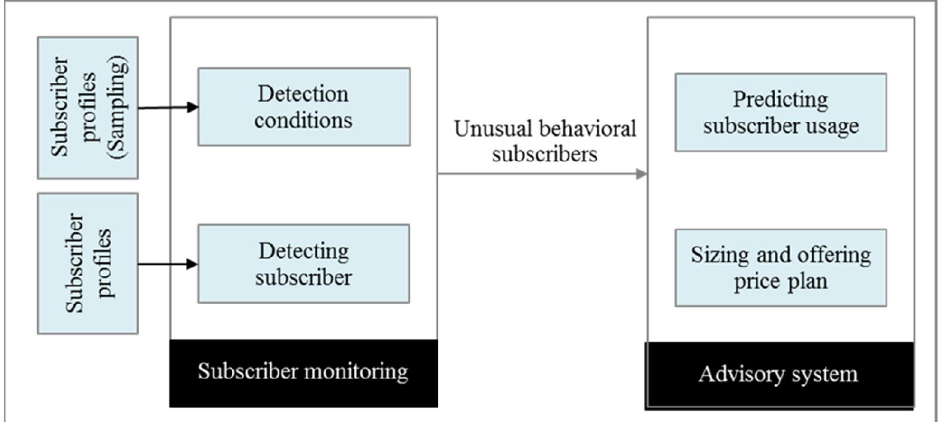
Fig. 2. System overview of Innovative price plan and monitoring and advisory system